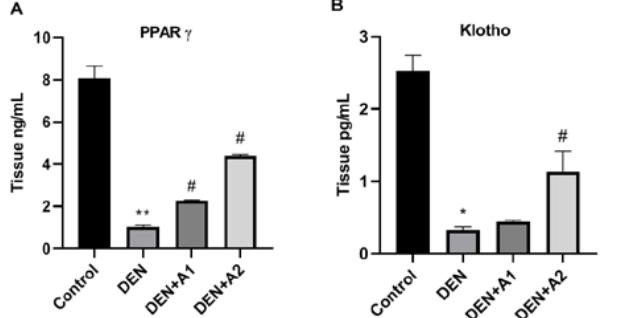
Figure 3. Effects of artichoke on ( A ) PPAR γ (Tissue ng/mL) and ( B ) Klotho (Tissue ng/mL) levels in brain tissue ( n = 8). Data are presented as means ± SD * p < 0.05, ** p < 0.001 vs. control group, # p < 0.05 vs. DEN group; DEN: diethylnitrosamine, A1: 0.8 g/kg artichoke, A2: 1.6 g/kg